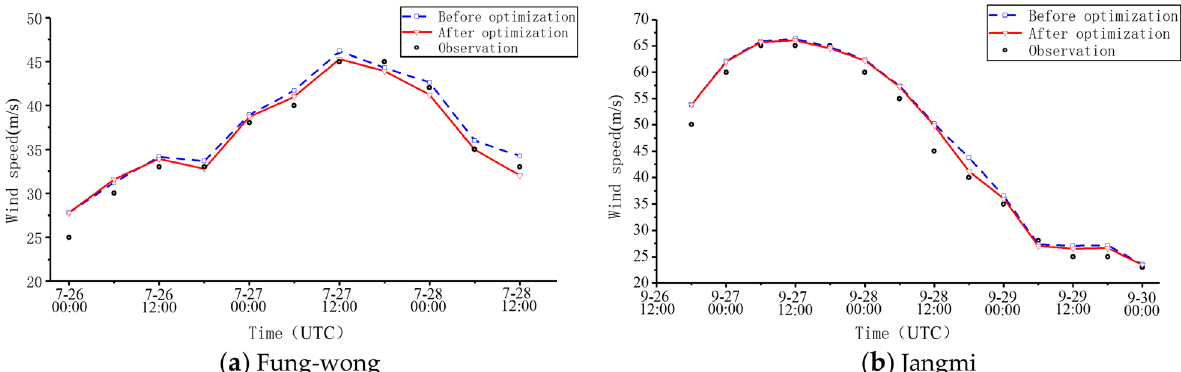
Fig. 5 Comparsion between simulated and measured maximum wind speeds of typhoon Fung-wong and Jangmi before and after